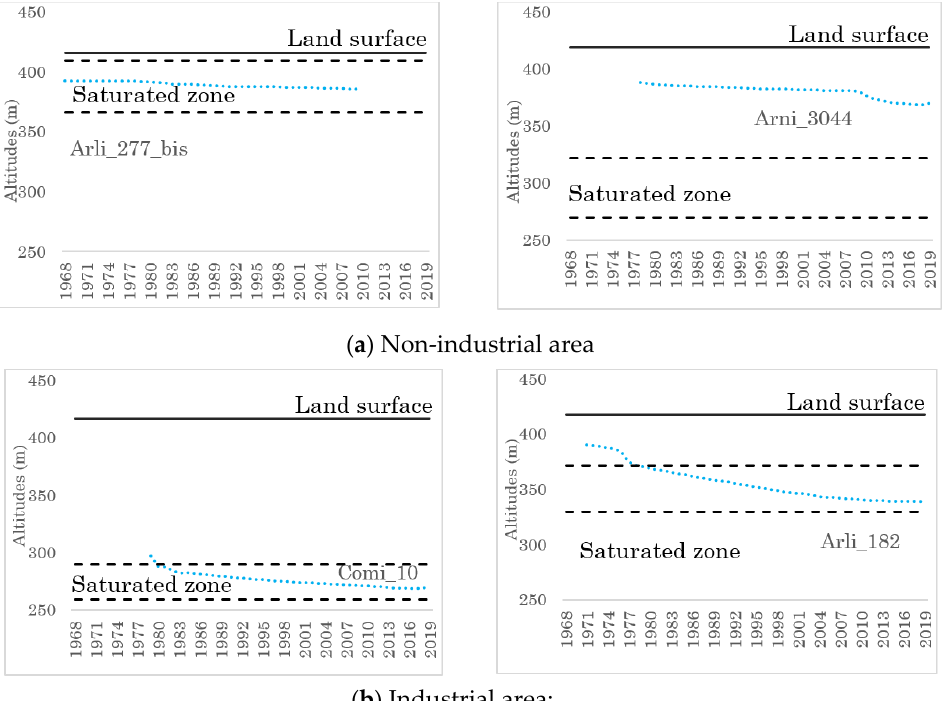
Figure 7. Hydrographs for selected piezometers. See Figure 5 for the piezometers’